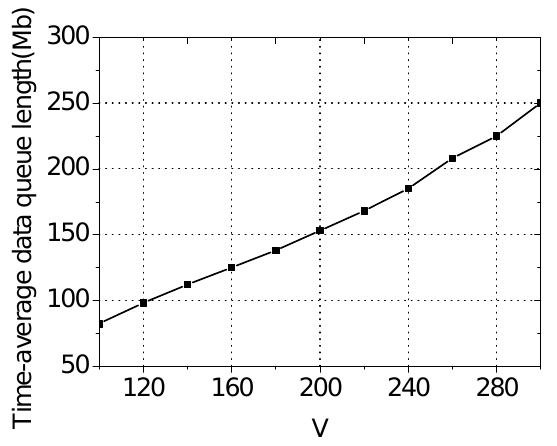
Figure 5. Time-average data queue length.